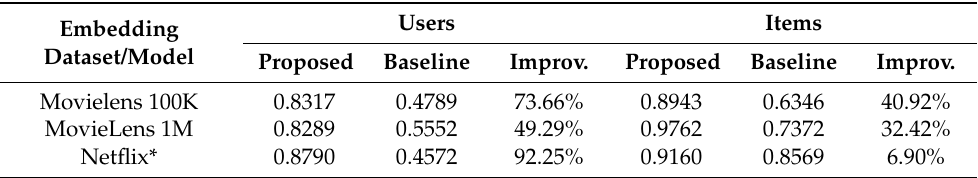
Table 3. Unpacking quality measure results (intra-clustering results from the quality measure defined in the ‘Experiment 2 (cid:48) ) for both user and item embeddings. The higher the quality value, the better the result. “proposed” and “baselines” are absolute values, whereas “improv.” shows the improvement percentage of the proposed model versus the baseline